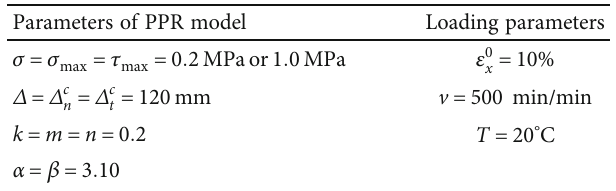
Figure 8: The mesh of the RVE model with Af equal to 60%. Table 3: Common parameters of PPR model and loading